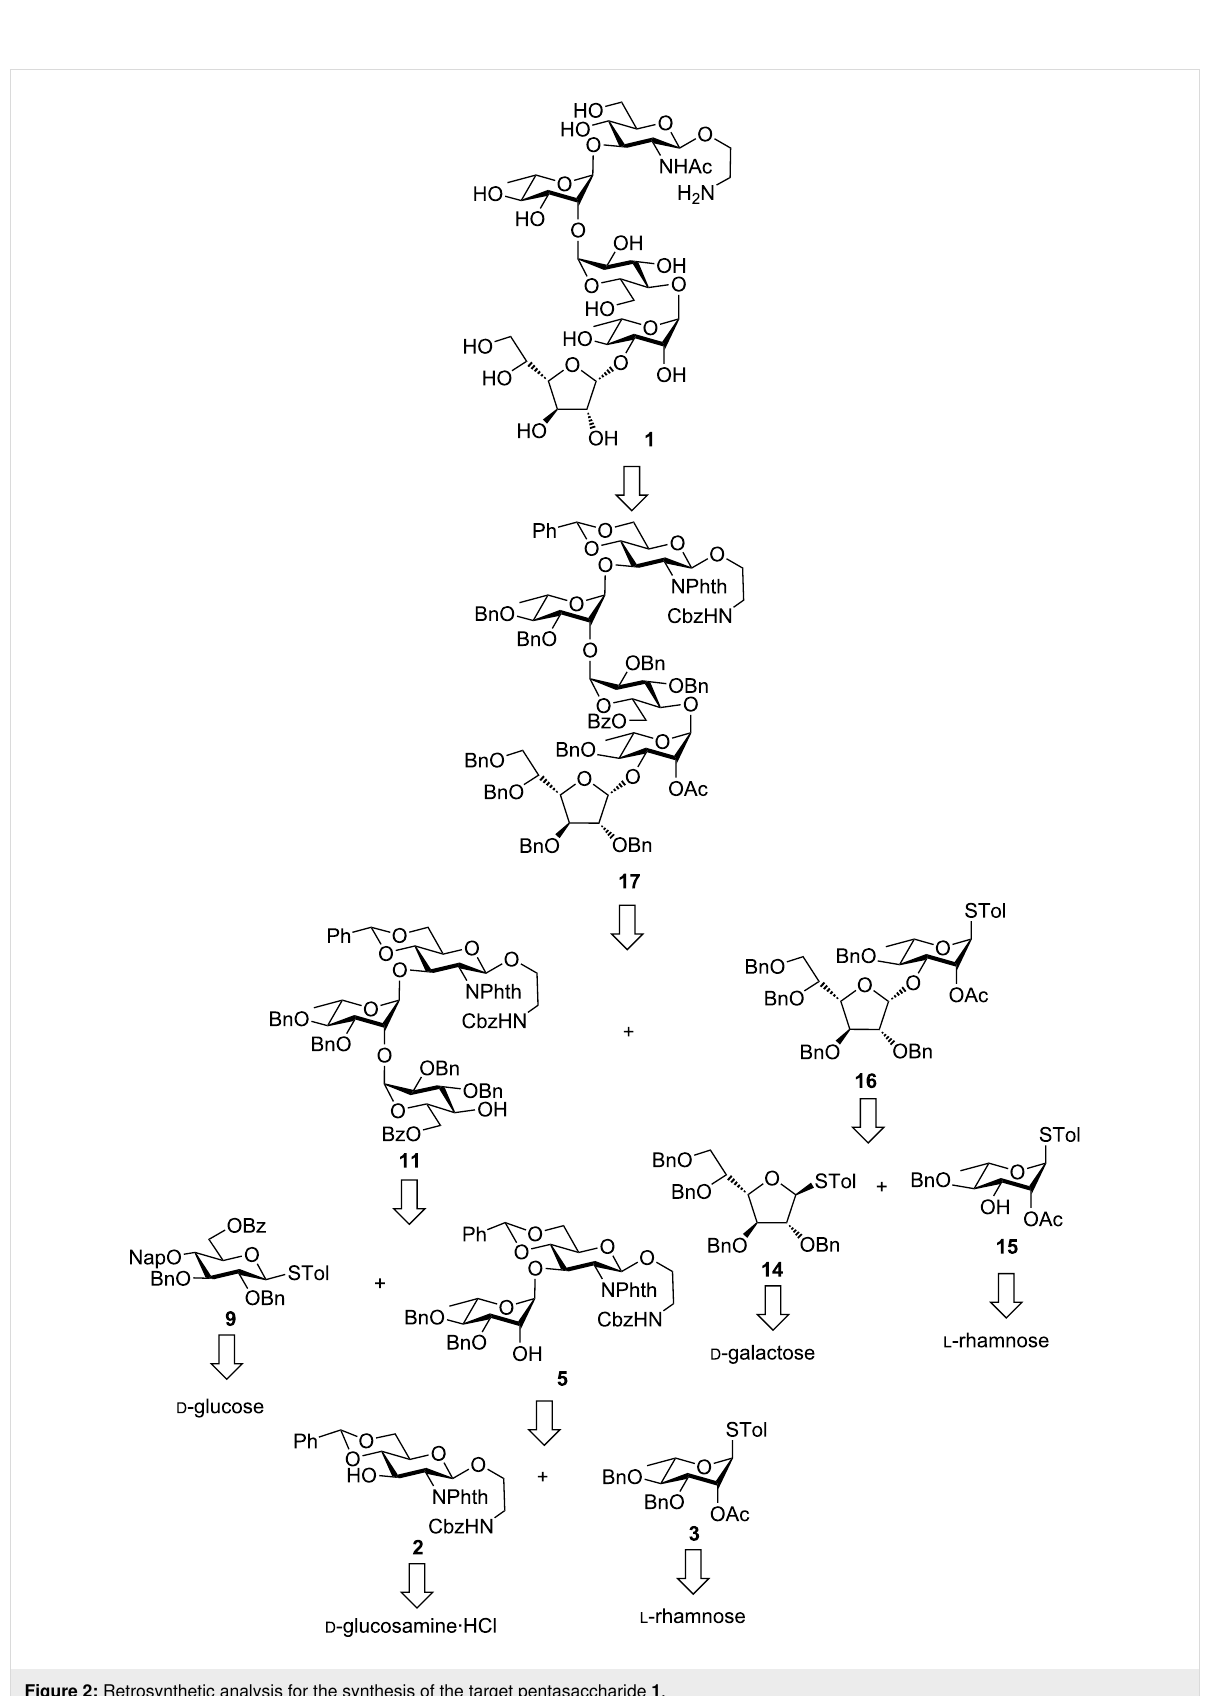
Figure 2: Retrosynthetic analysis for the synthesis of the target pentasaccharide 1